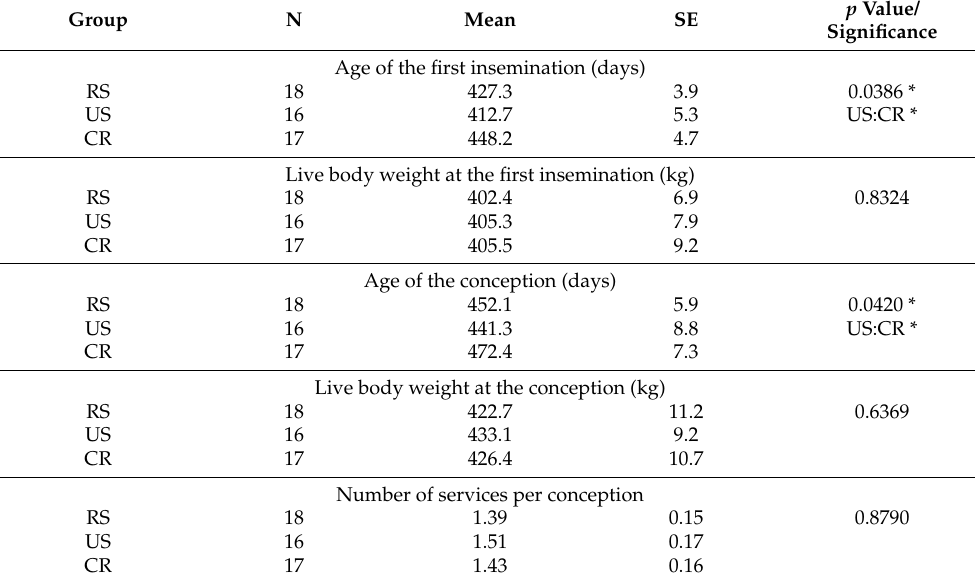
Table 3. Effect of treatment rearing on the reproduction parameters of